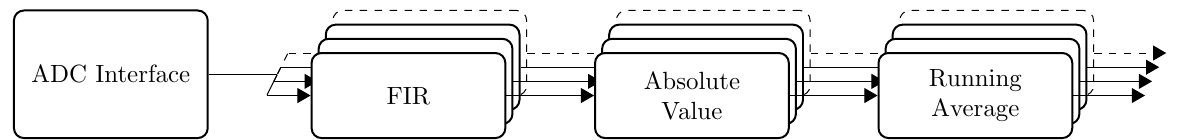
Figure 4. Signal conditioning based on the FIR filter approach. The output of the running average is processed by the signal